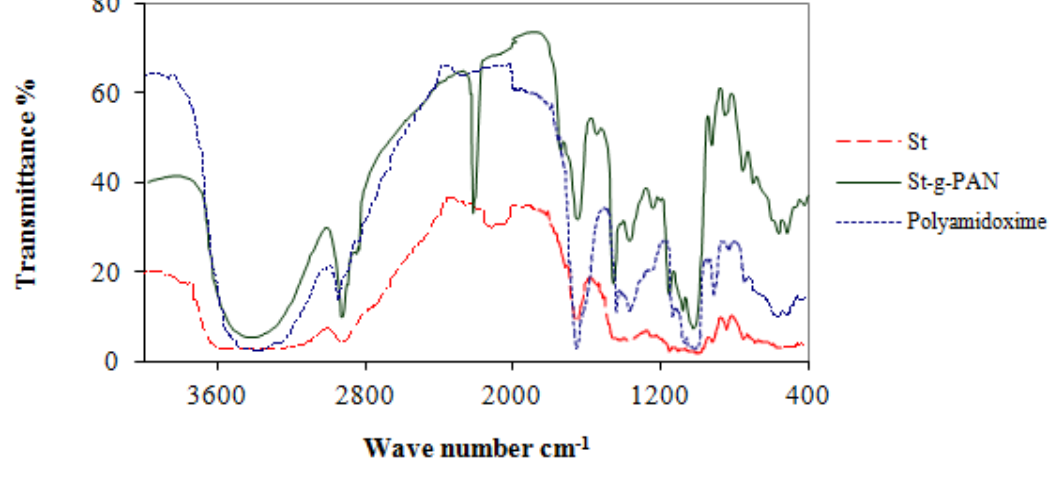
Figure 1. FTIR spectrum of starch, St- g -PAN and polyamidoxime